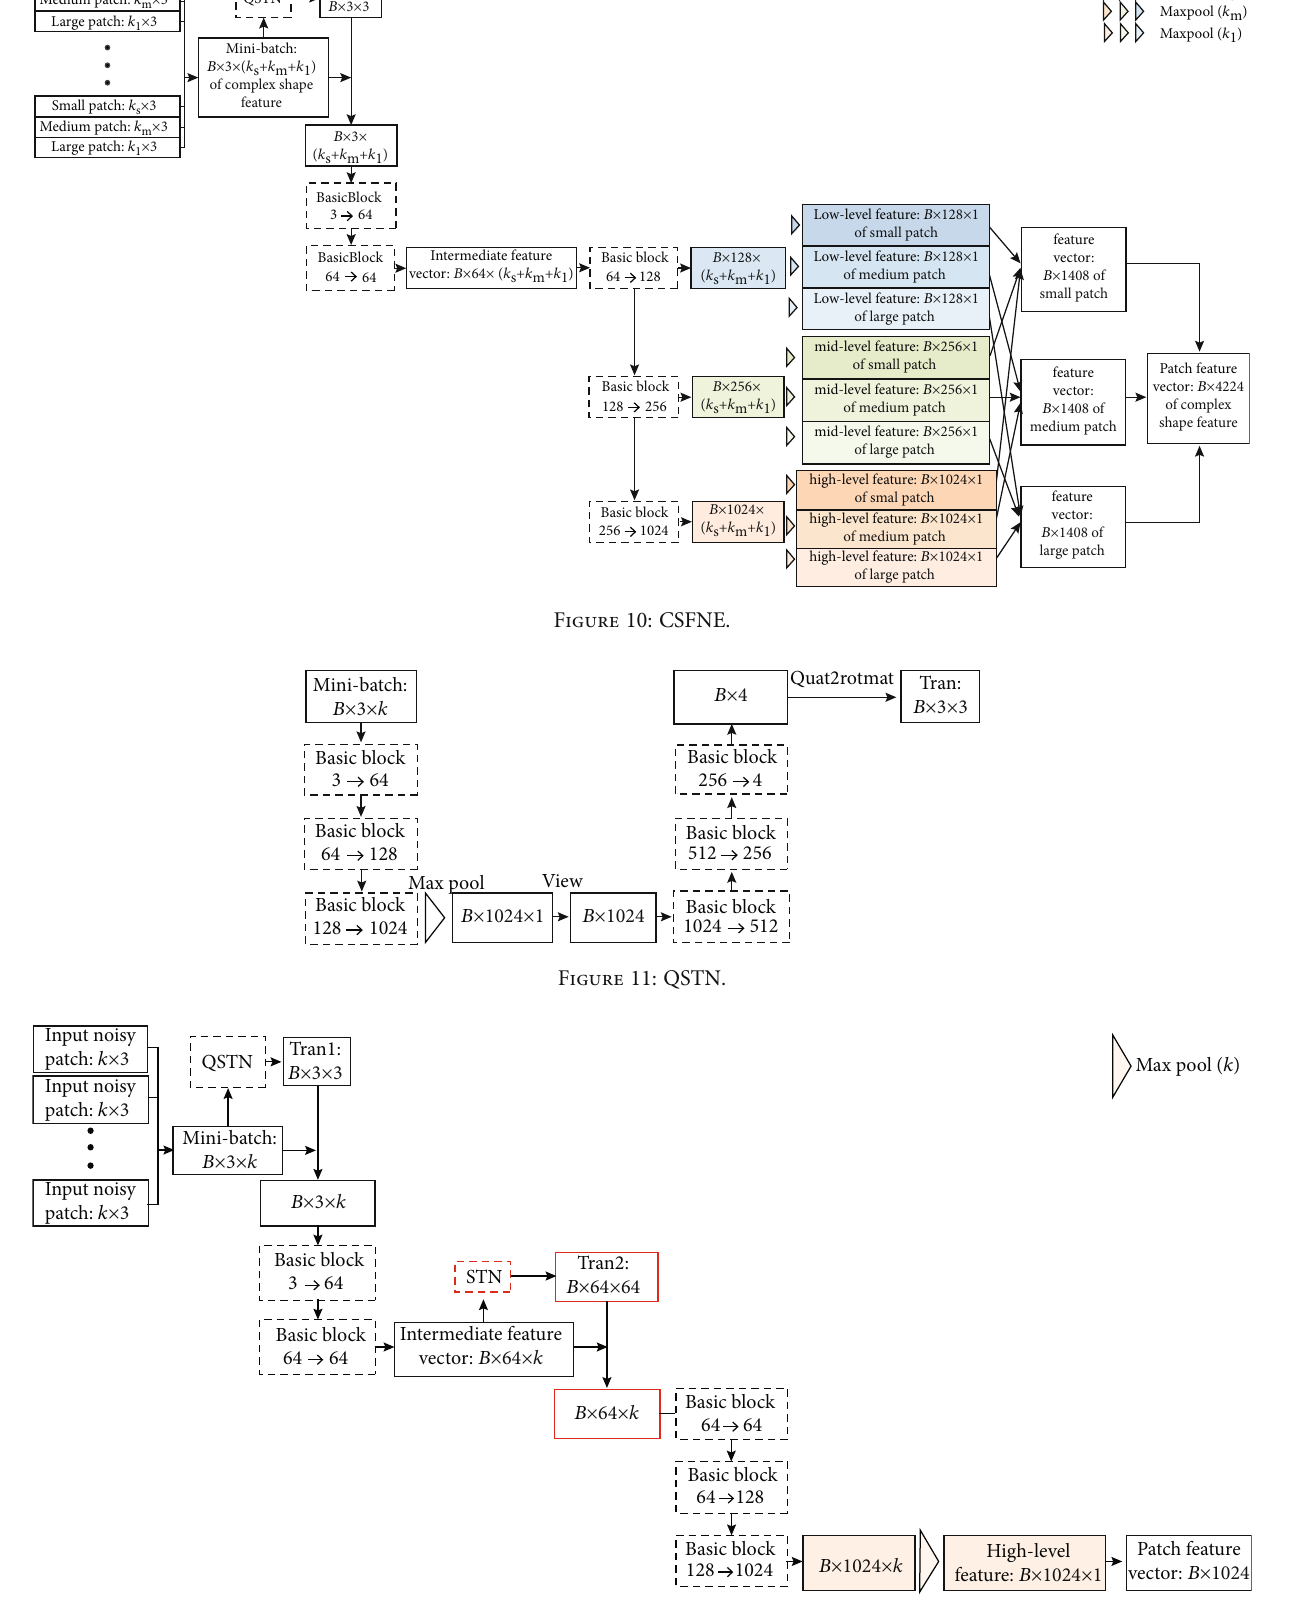
Figure 12: The neighborhood encoder of